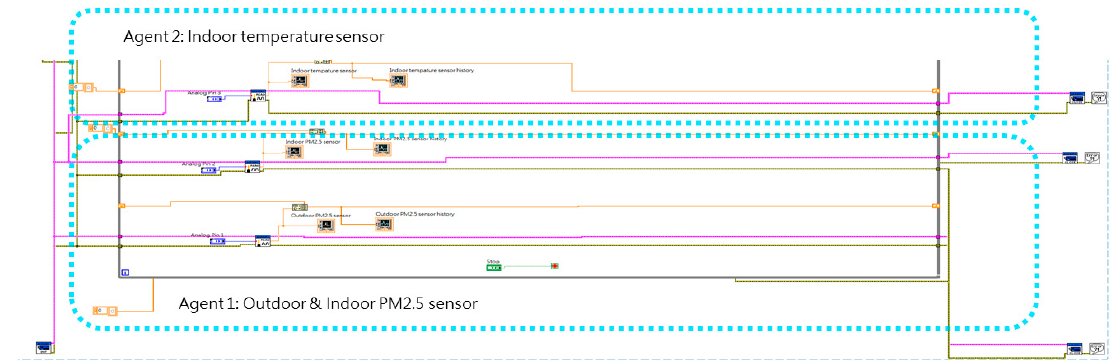
Figure 13. Full view of the LabVIEW multi-agent program.